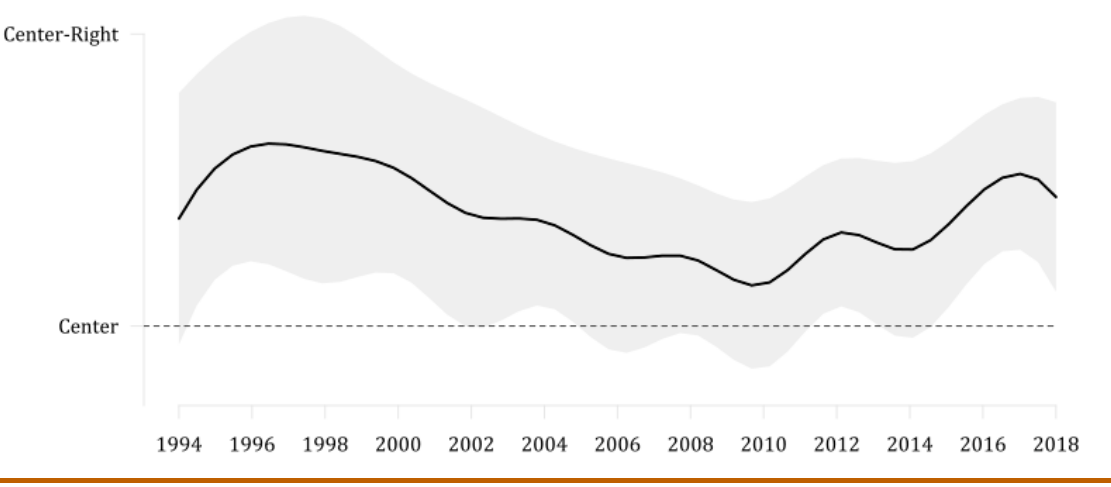
Figure 1: Unweighted mean and SD intervals for the Municipal Ideological Score (1994-